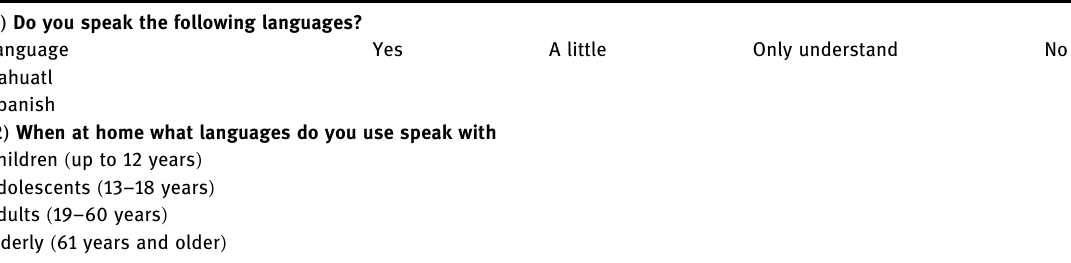
Table 1: Language questionnaire